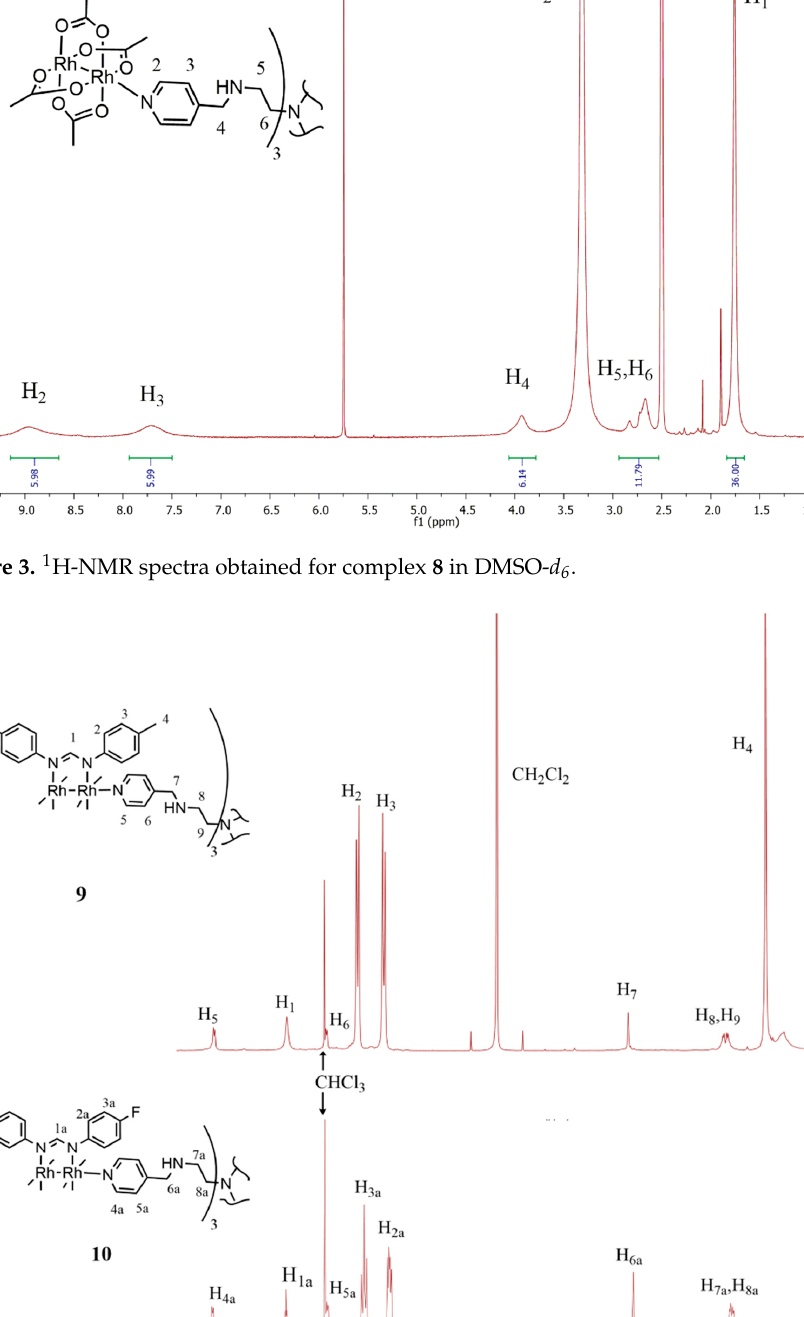
Figure 4. The 1 H-NMR spectra obtained for 9 (above, DCM additive) and 10 (below) in CDCl 3 .